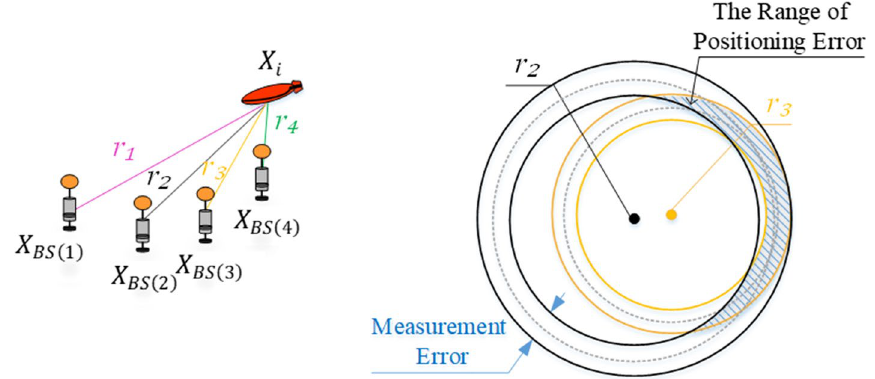
Fig. 3 Centrally distributed baseline and positioning